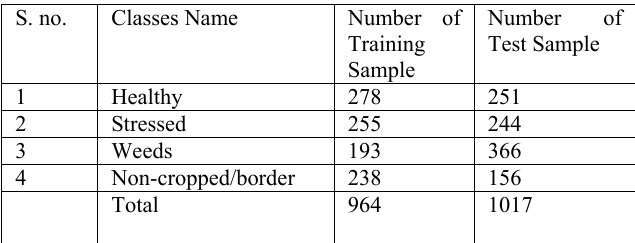
Table 1. Number of training and tested samples collected from maize fields for UAV image classification